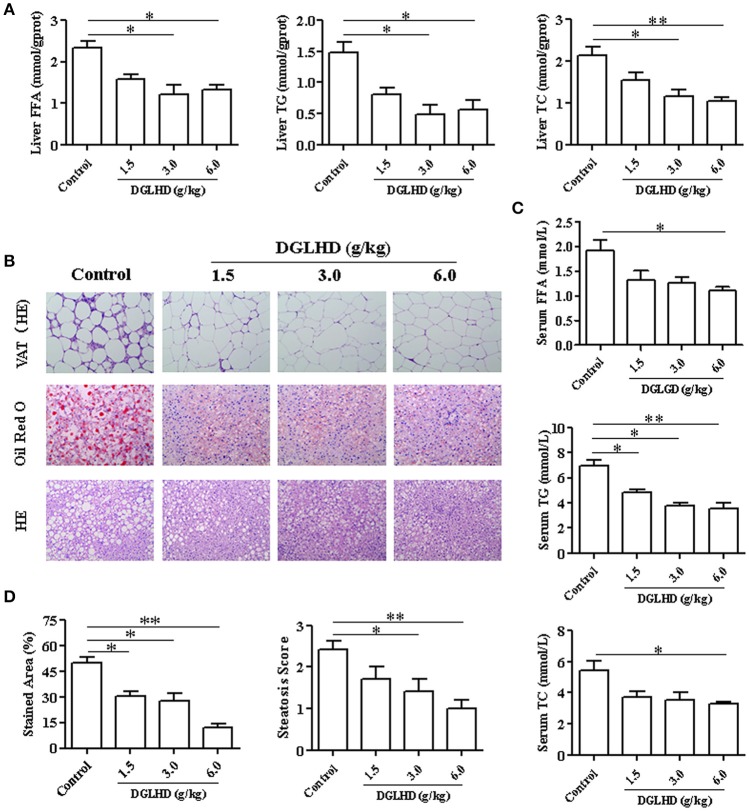
Effects of DGLHD on fat accumulation in ob/ob mice. Ob/ob mice were treated daily with water or DGLHD at 1.5, 3.0, or 6.0 g/kg by intragastric gavage for 8 weeks (n = 8 for each group). (A) The levels of free fatty acid (FFA), triglyceride (TG), and total cholesterol (TC) in liver. (B) Representative photomicrographs of VAT stained with hematoxylin-eosin; Representative images of liver sections stained with Oil Red O or hematoxylin-eosin (×200). (C) Concentrations of FFA, TG, and TC in serum. (D) Steatosis area and scores of liver in different groups. Data are expressed as mean ± SEM (n = 5). *P < 0.05, **P < 0.01 vs. Control.